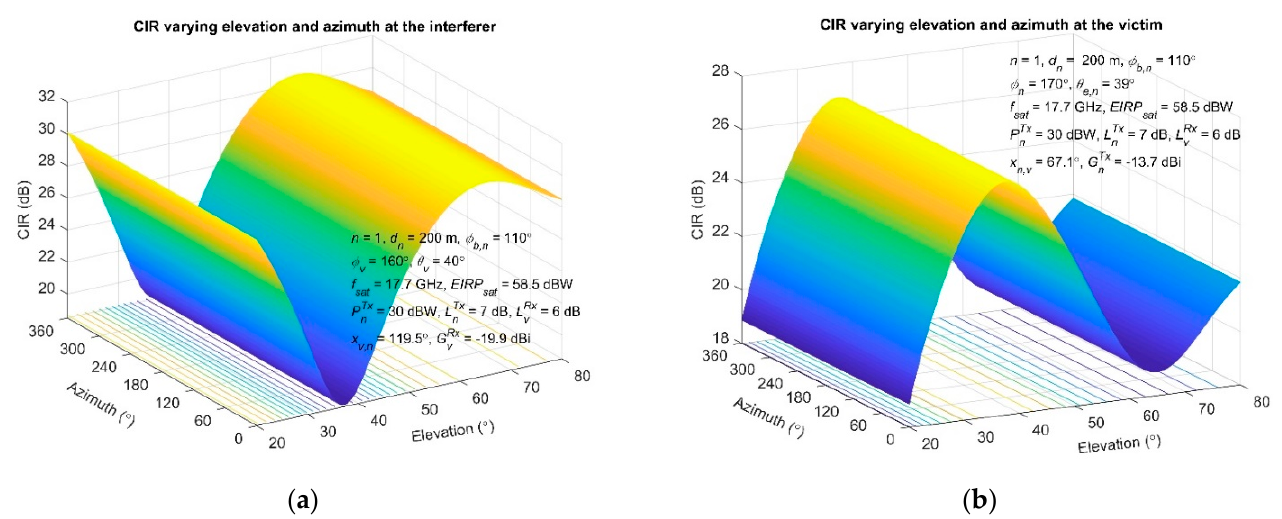
Figure 5. Achieved CIR at the victim side, varying the elevation and azimuth: ( a ) at the interfering station; ( b ) at the victim station.